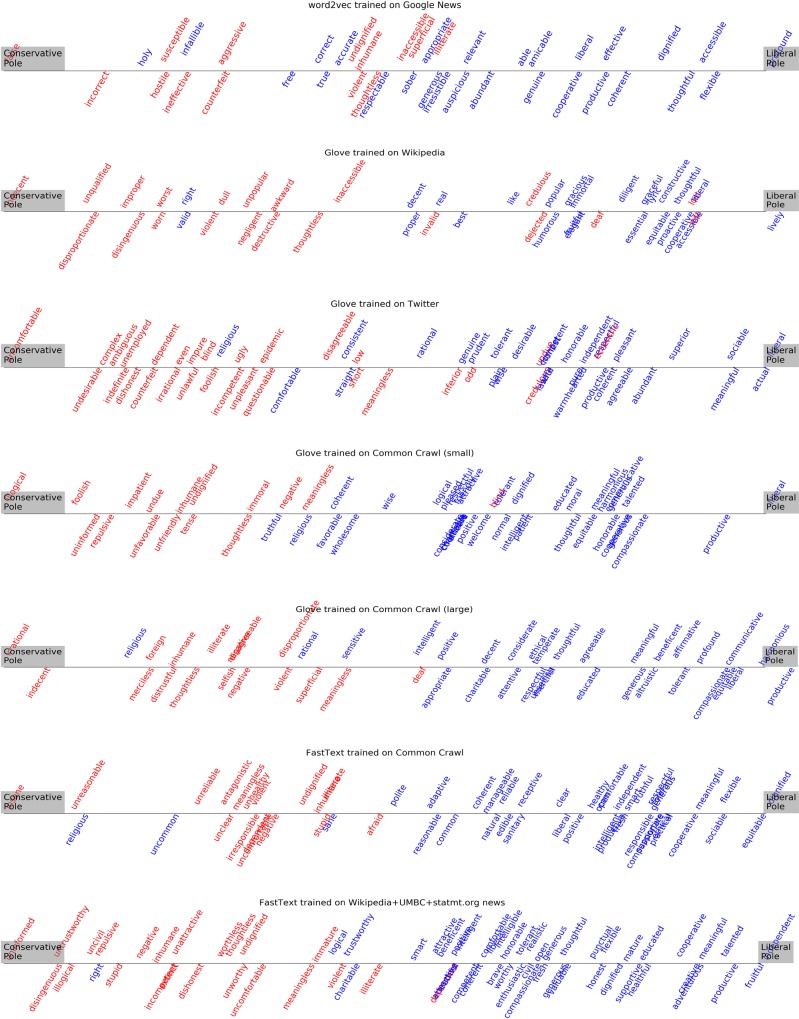
HGI sentiment lexicon words among Wordnet top 100 antonym pairs derived axes that better align in orientation with the conservatives to liberals cultural axis in 7 popular pre-trained embedding models.Words have been color-coded red and blue to signify negative and positive labels. The word ‘progressive’ has been left out from the figure since it was an outlier in several axes that distorted the visualization.